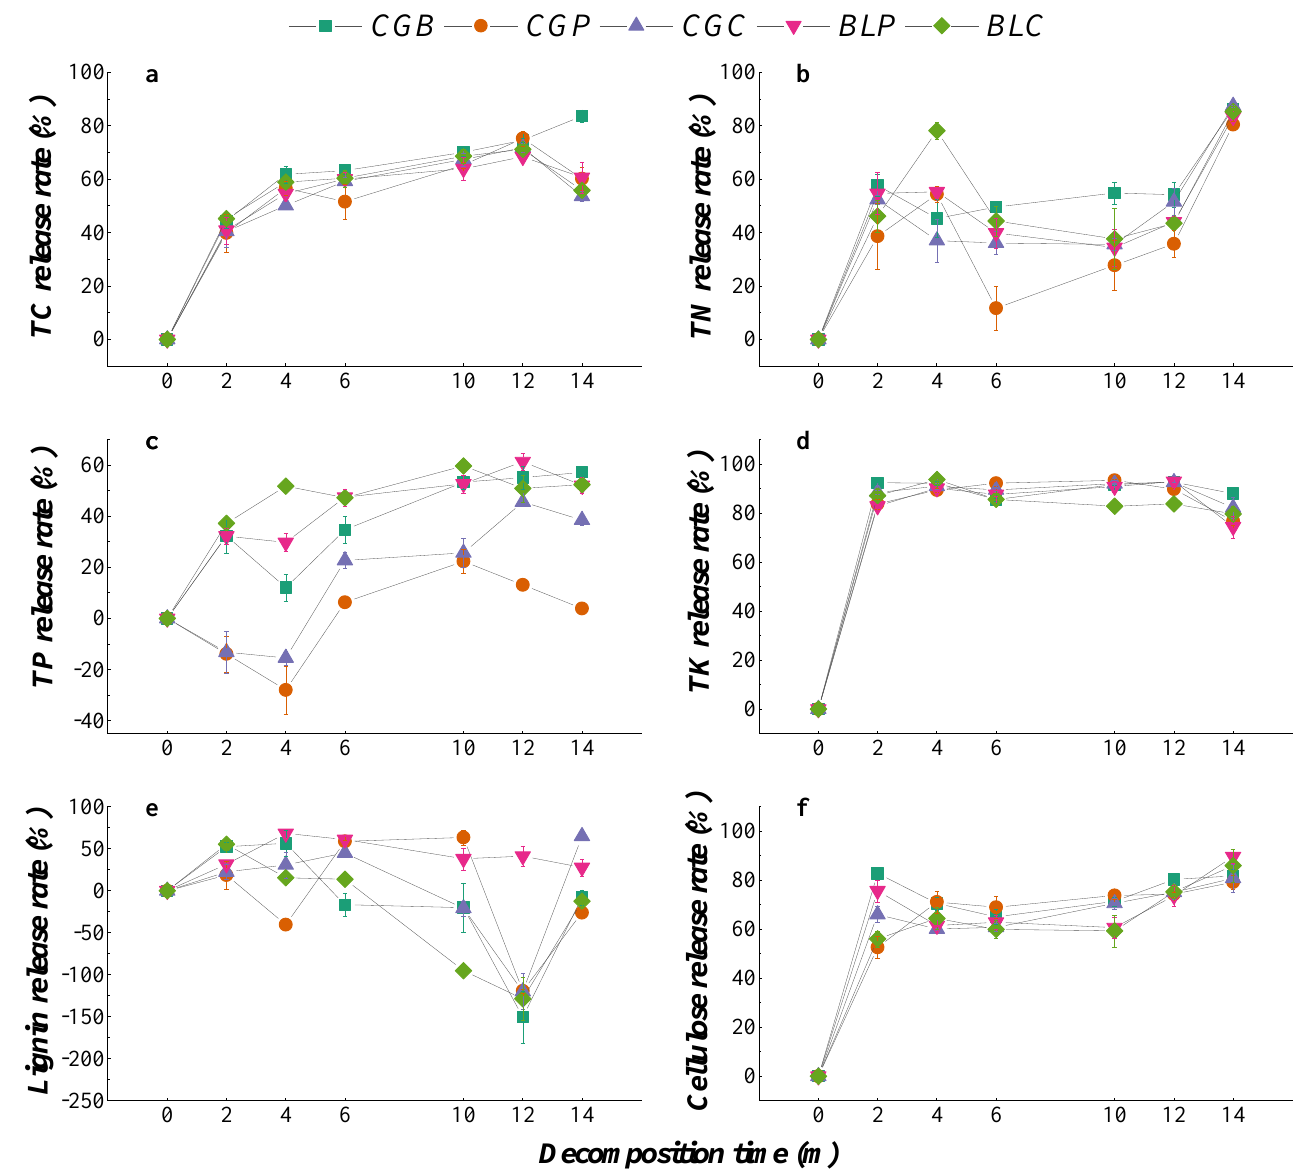
Figure 5. Nutrient release rates of different leaf litters in the decomposition process. ( a – f ) represents the TC release rate, TN release rate, TP release rate, TK release rate, Lignin release rate and Cellulose release rate.